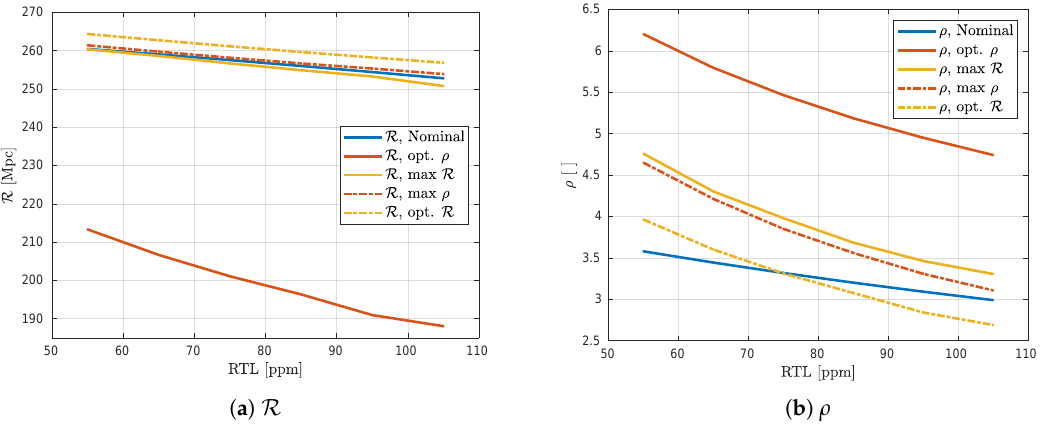
Figure 5. Sensitivity parameters as functions of round trip losses (RTLs). ‘Opt’ corresponds to an optimal primary parameter, while ‘max’ corresponds to a maximum secondary parameter within a budget of the optimal primary parameter. Nominal configurations that use the currently expected input mirror (IM), power recycling mirror (PRM), and signal recycling mirror (SRM) transmittances are shown for